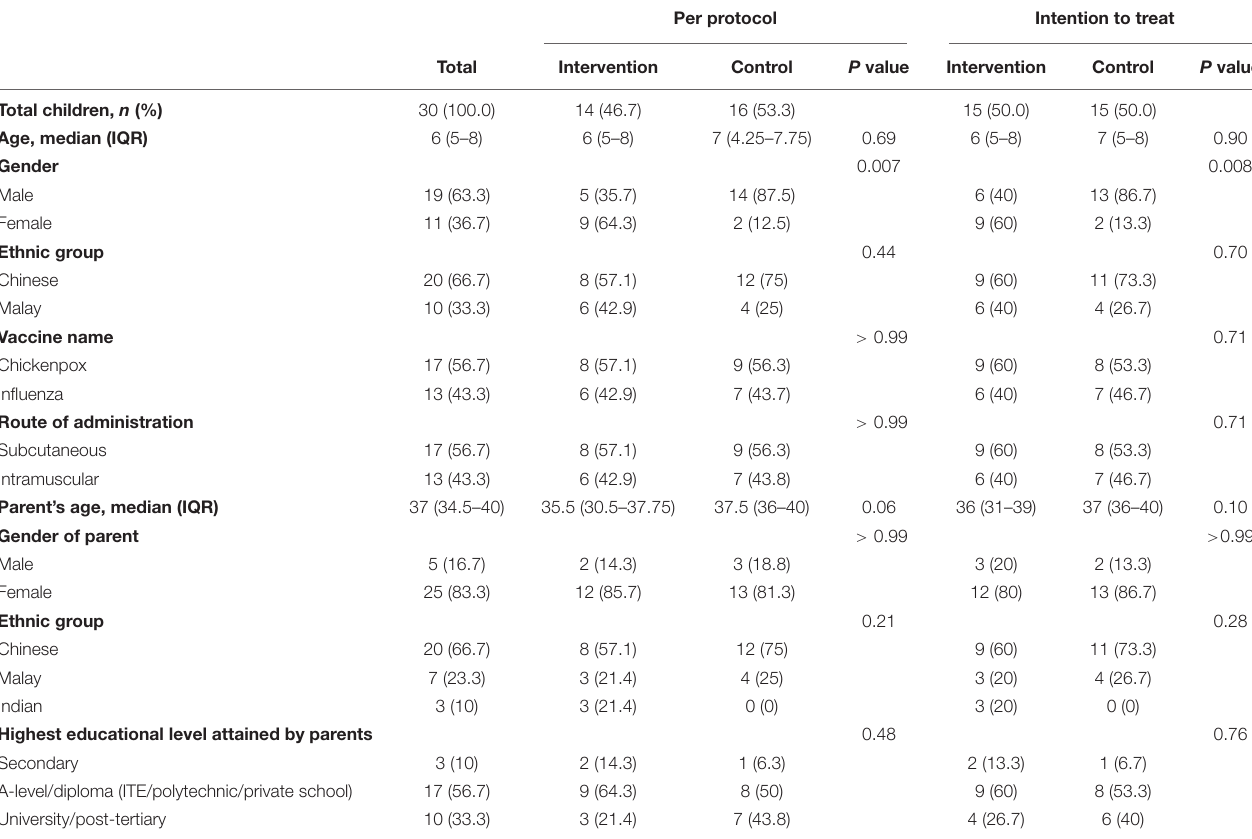
TABLE 1 | Baseline characteristics of children and parents ( n = 30).